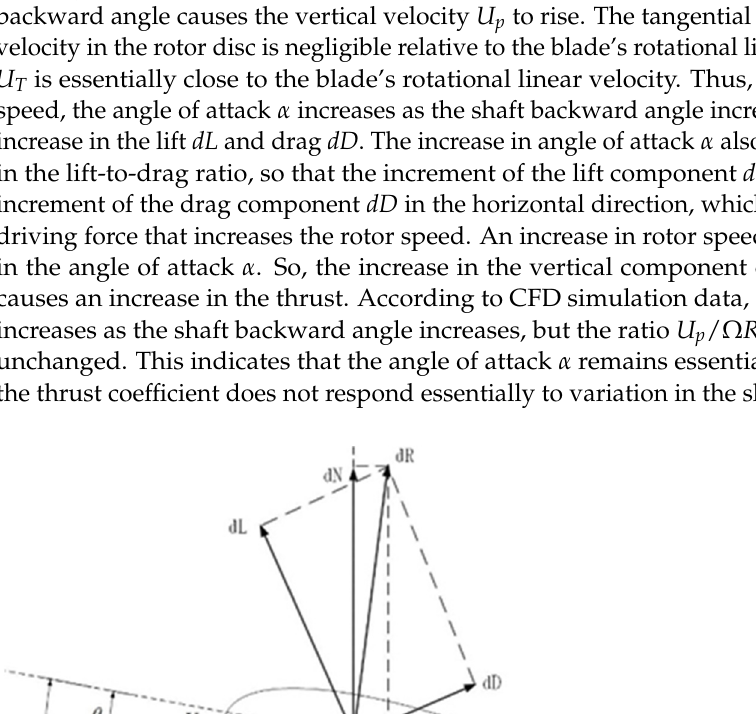
Figure 18. The thrust and thrust coefficient with δ s .